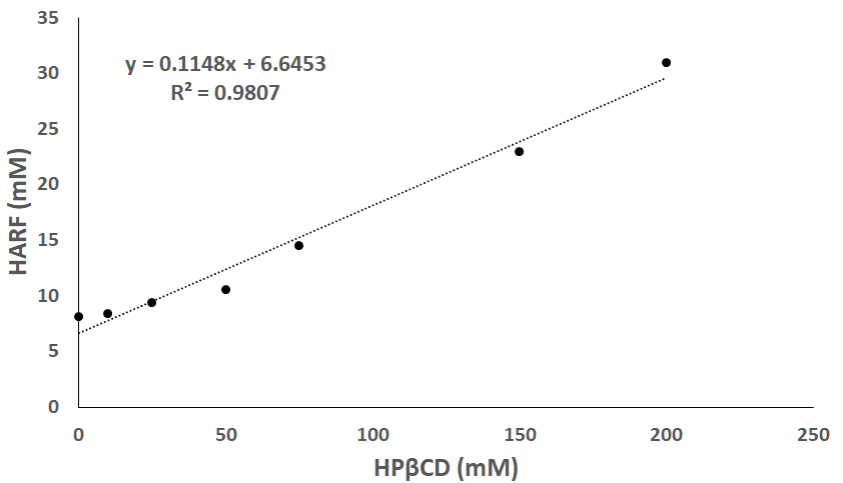
Figure 1. Phase solubility diagram of HARF in the presence of several mixtures containing succes- sively increasing concentrations of HP β CD.